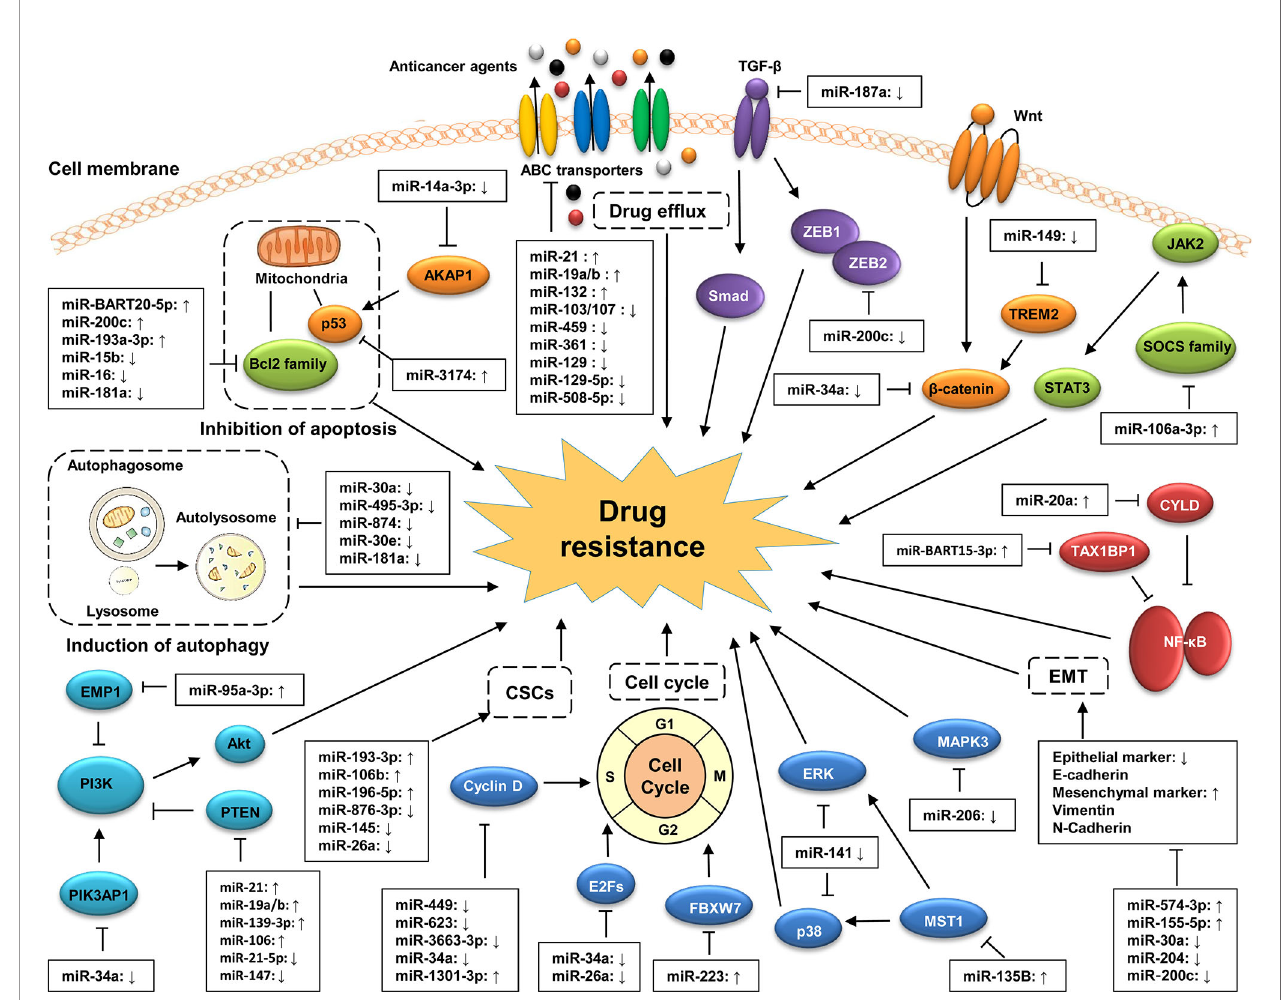
FIGURE 2 | Classic mechanisms of miRNA involved in the drug resistance of GC. MiRNAs participate in the development of GC drug resistance by regulating multiple biological processes of GC cells, including drug ef fl ux, cell apoptosis, cell cycle, and EMT as well as the acquisition of cancer stem cell (CSC) properties. MiRNAs also involves in the regulation of GC drug resistance by targeting cancer-related signaling pathways, such as the PI3K/Akt, Wnt/ b -catenin, MAPK, TGF- b / Smad, and NF- k B signaling